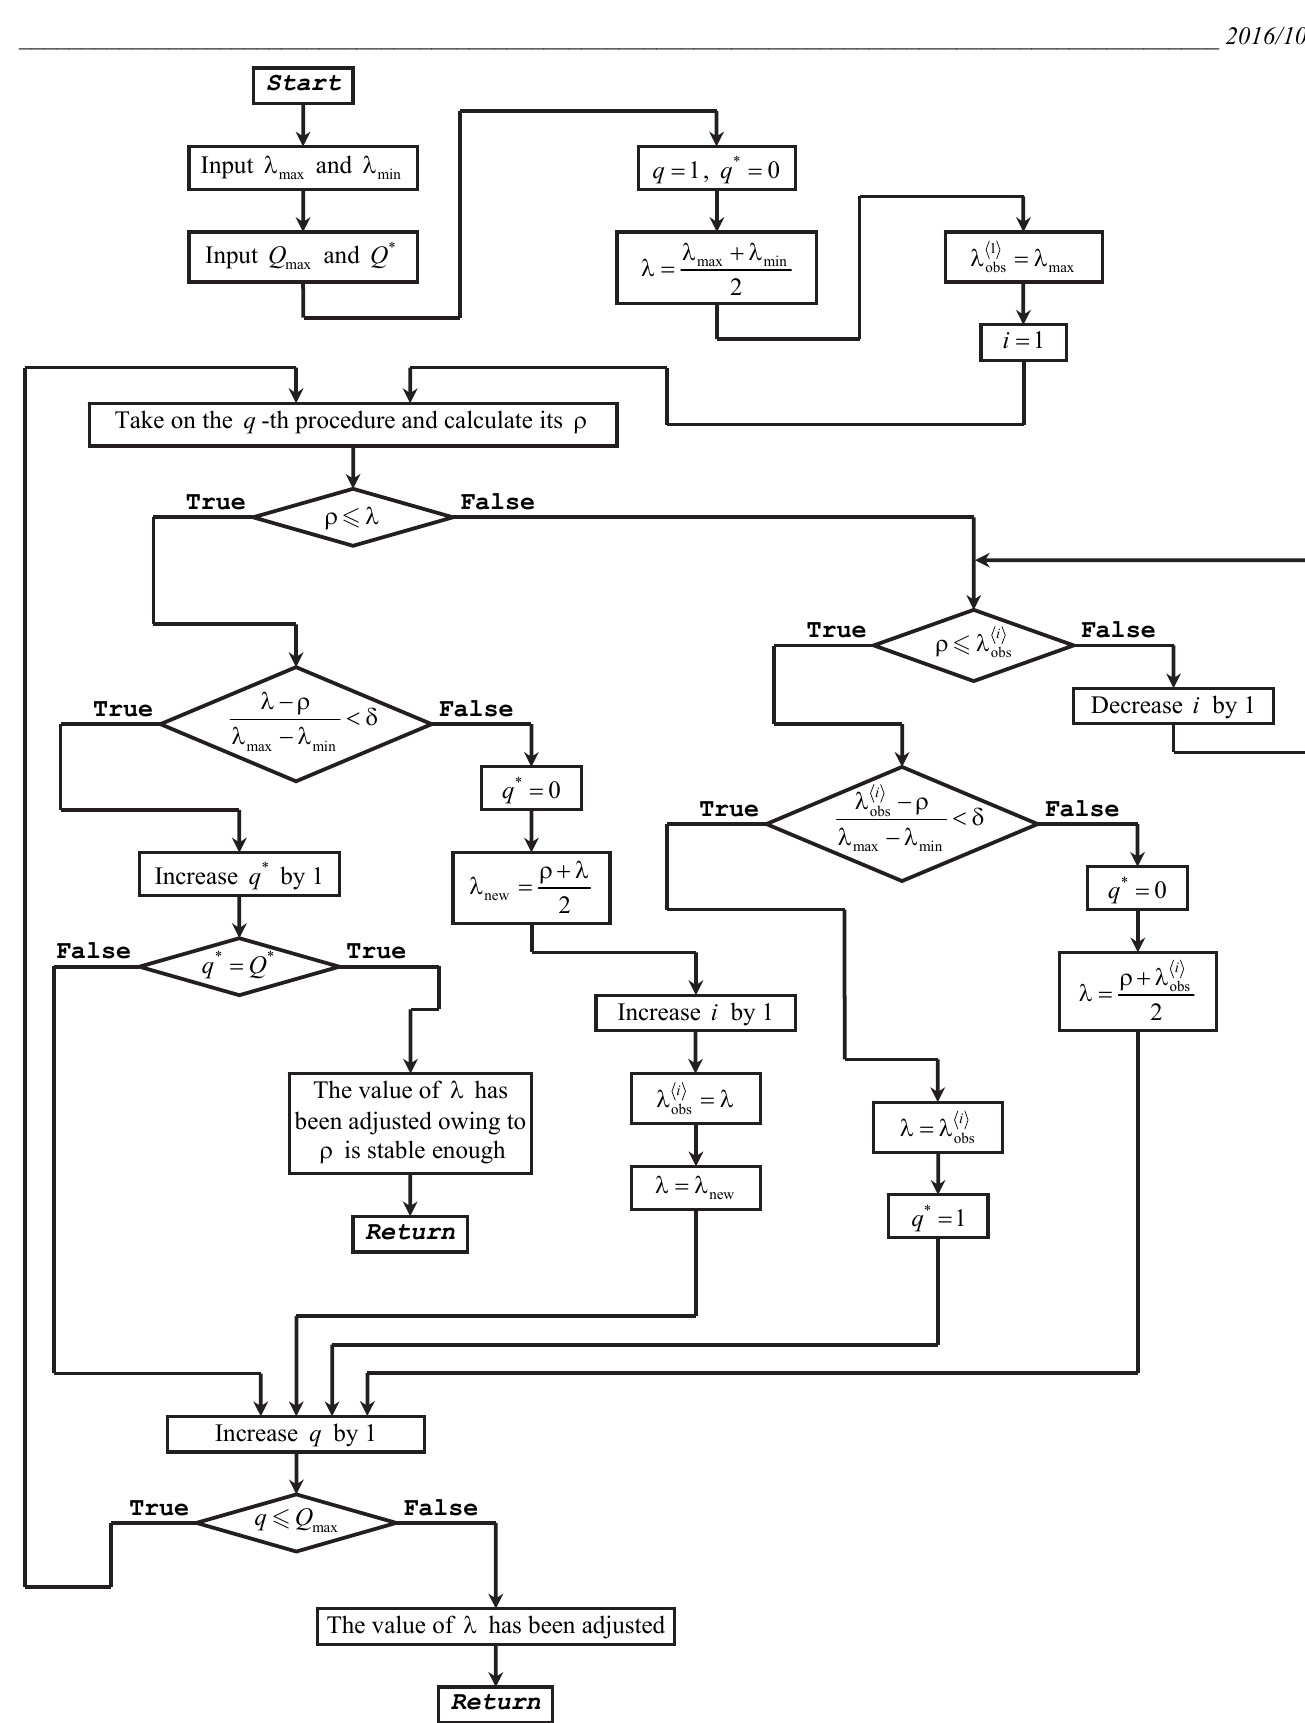
Fig. 3. A soft adjusting algorithm. False inequality (1) gives smarter conditions to get a new  . The control of the recurring closeness of  to  is maintained to fit the hard adjusting algorithm in Fig. 2. The algorithm stage, where the current expert procedure number is increased by 1, is supplied already with four